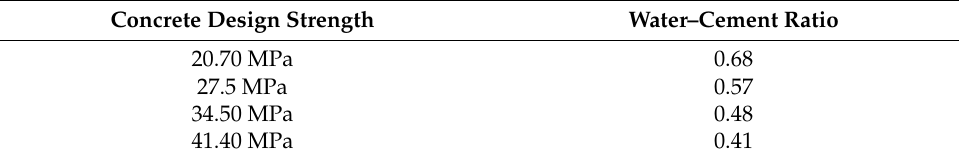
Table 2. Design strength and corresponding water–cement ratio.